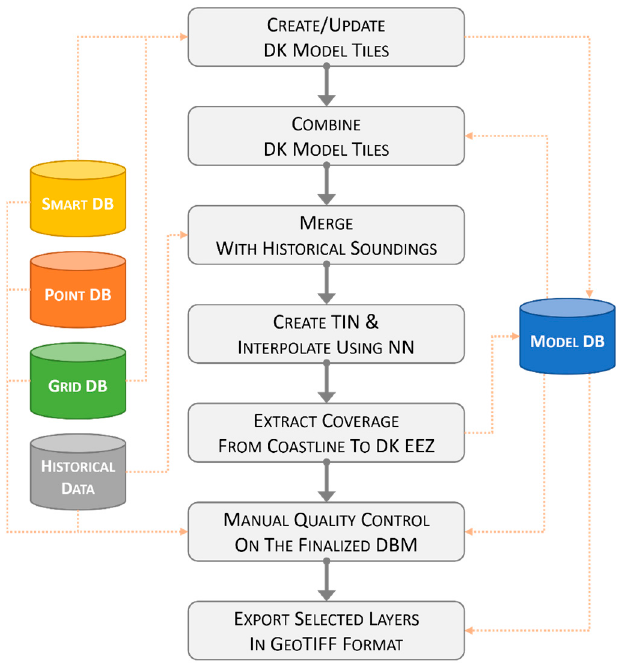
Figure 2. Workflow showing the main steps of the compilation approach (connected using grey arrows). The access (read/write) to DYBDB databases and the retrieval of historical data are shown using orange dotted connectors. Acronyms used in the workflow: DK for Denmark, EEZ for Exclusive Economic Zone, NN for the Natural Neighbor algorithm.